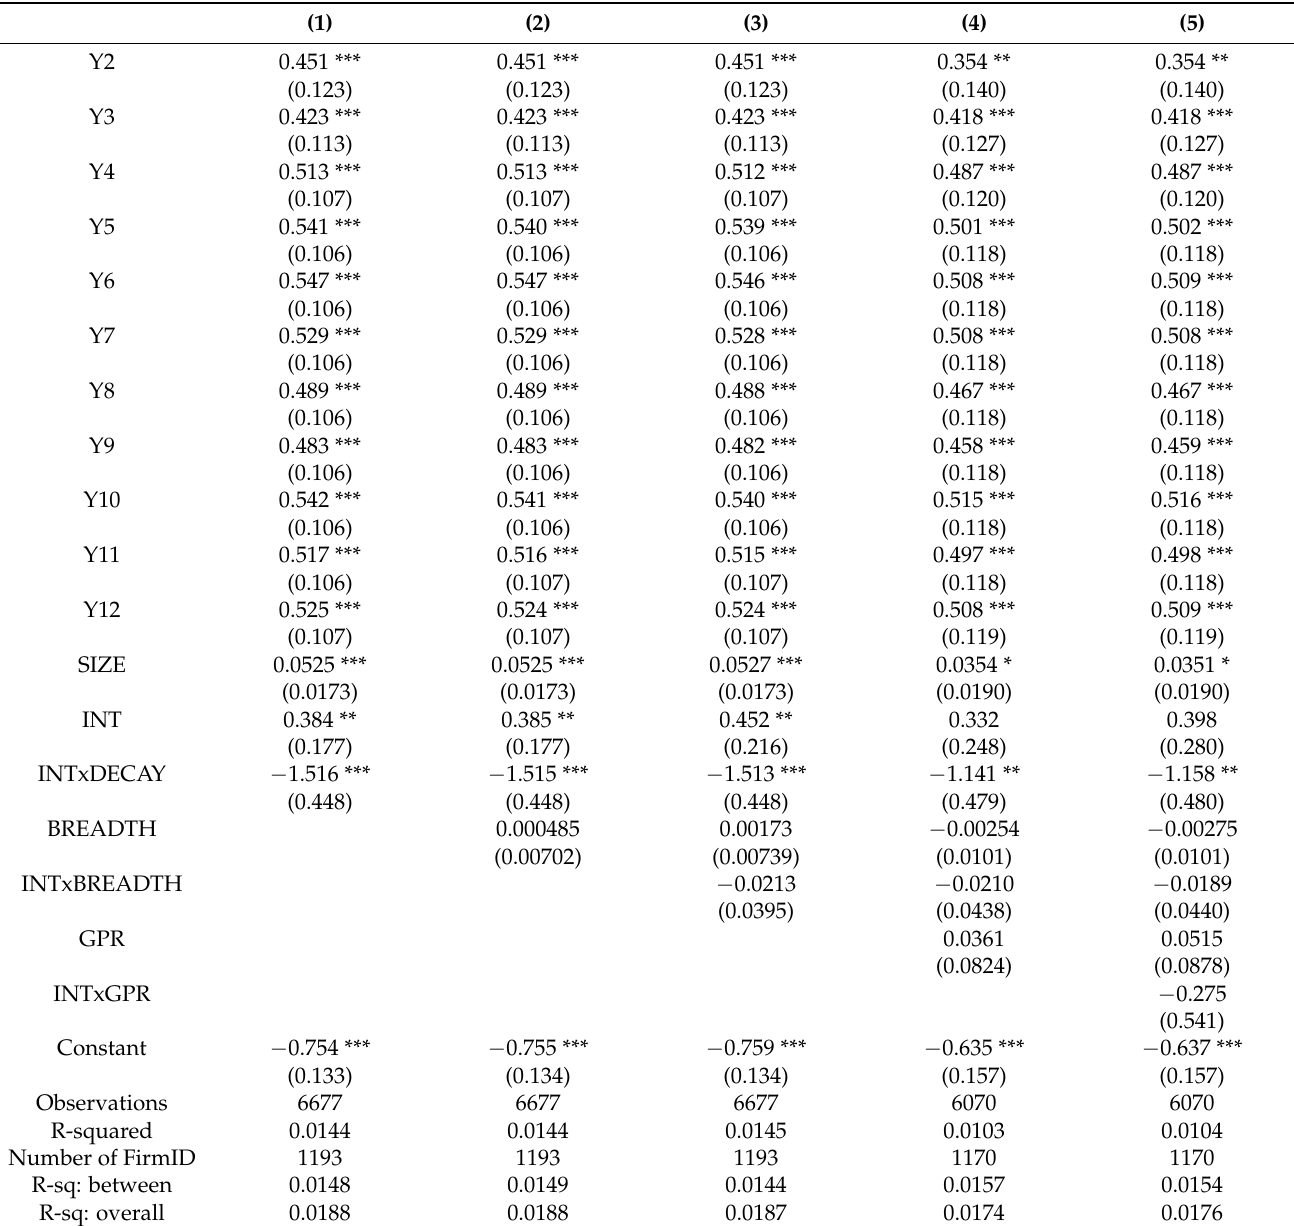
Table A2. Effect of breadth and GPR on